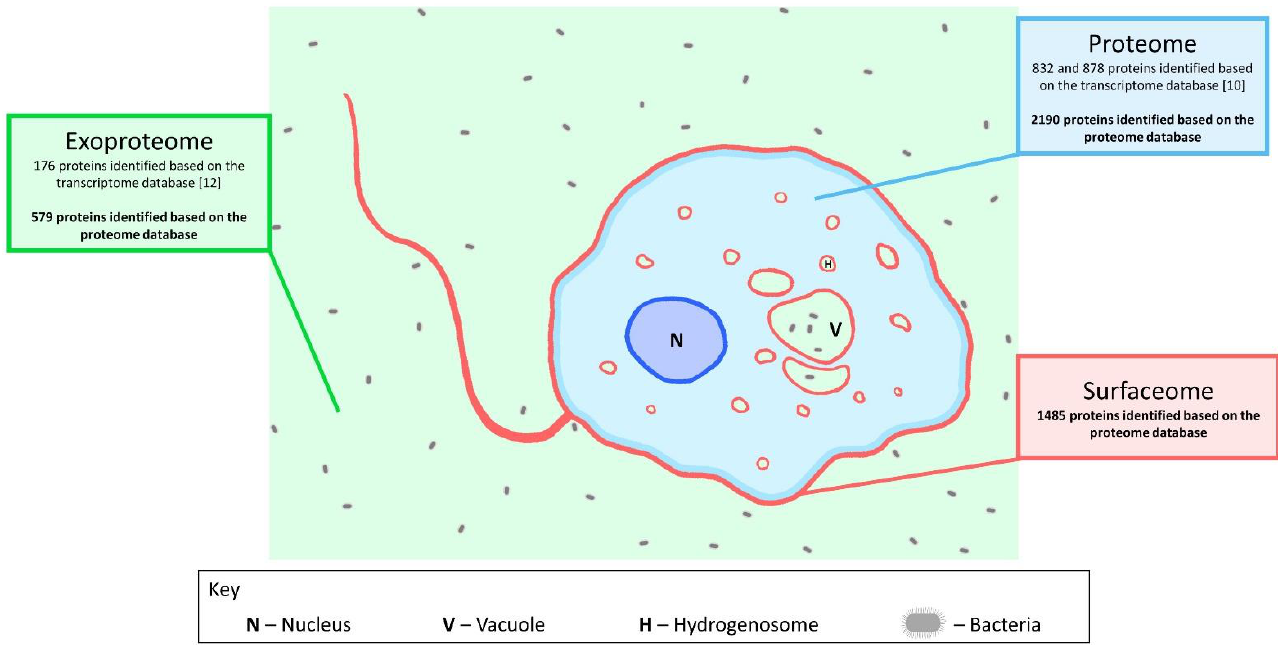
Figure 5. Schematic representation of the major H. meleagridis proteomic analyses to date.